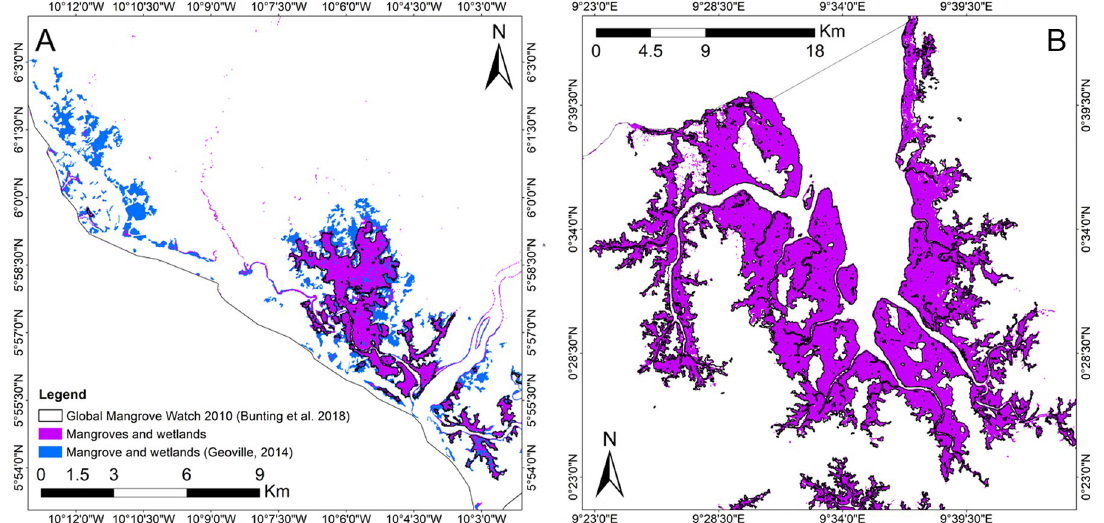
Fig 10. Comparison between our predicted land cover maps, the latest land cover land use product available for Liberia for 2014 and the global mangrove extent product for 2010. Comparisons were made between selected areas of the Mangroves and Wetland class from both Liberia (A) and Gabon (B) maps. While our maps show good agreement with the global extent product, an overestimation of Mangrove and Wetland areas by the previous land cover product available for Liberia was found (shown in blue).